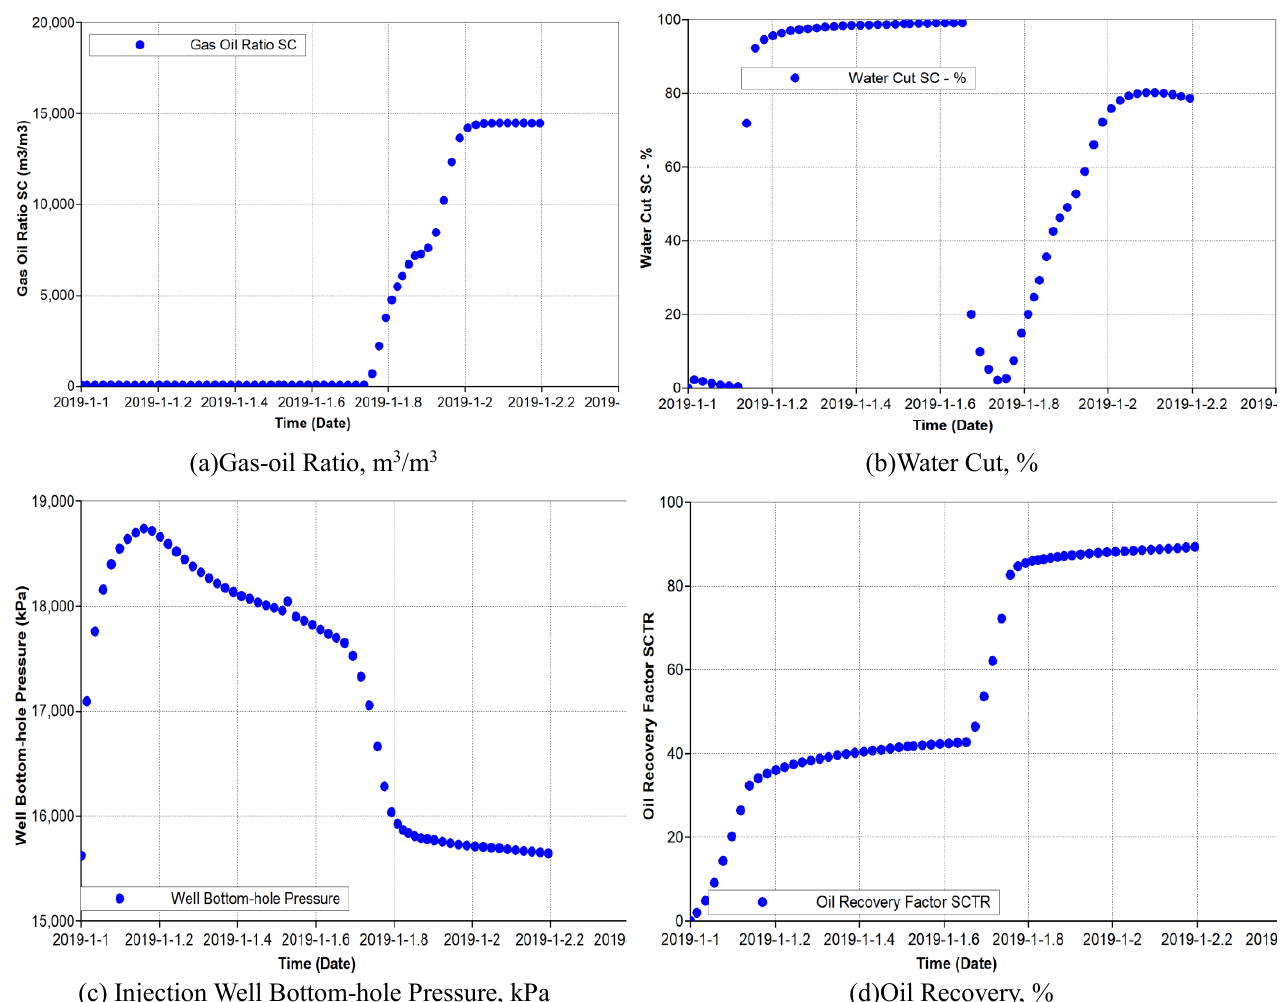
Figure 4—Results of displacement experiment of the low-permeability